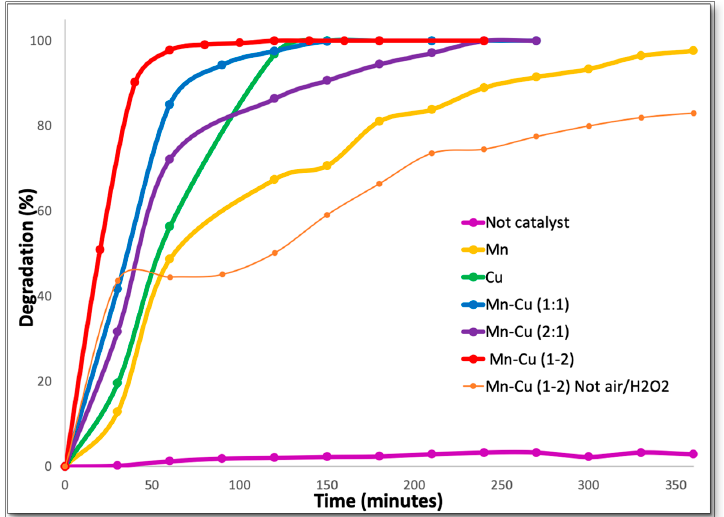
Catalysts 2019 , 9 , x FOR PEER REVIEW Figure 5. Catalytic activity for CWPO of CV by Mn–Cu catalyst. Figure 5. Catalytic activity for CWPO of CV by Mn–Cu catalyst. Table 4. Catalytic activity in CV degradation of Mn–Cu catalyst.